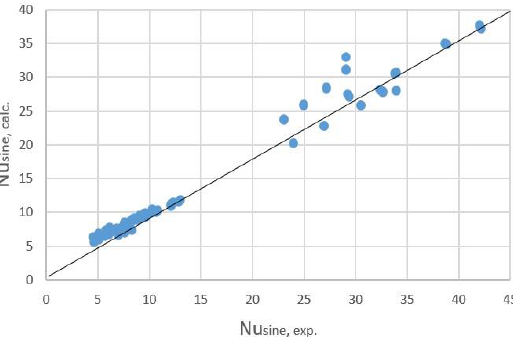
Figure 3. Comparison between the experimental Nu sine values and those computed with the model (Equation